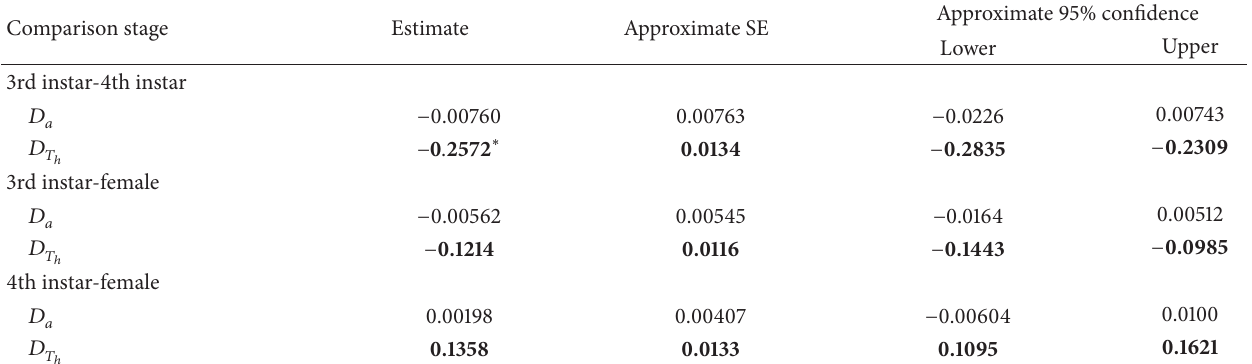
Table 4: Parameters estimated by an equation with indicator variable for comparing type III functional response parameters of 3rd and 4th instar larvae and females of N. arcuatus